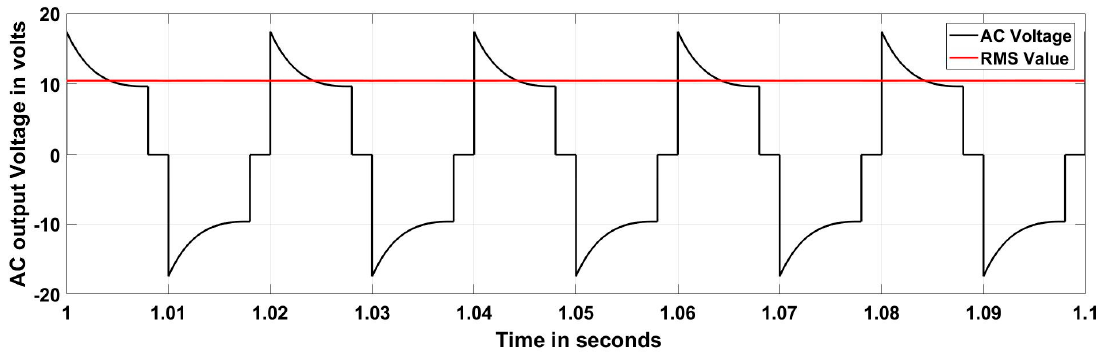
Figure 15. Control pulse for inverter mode in buck mode.